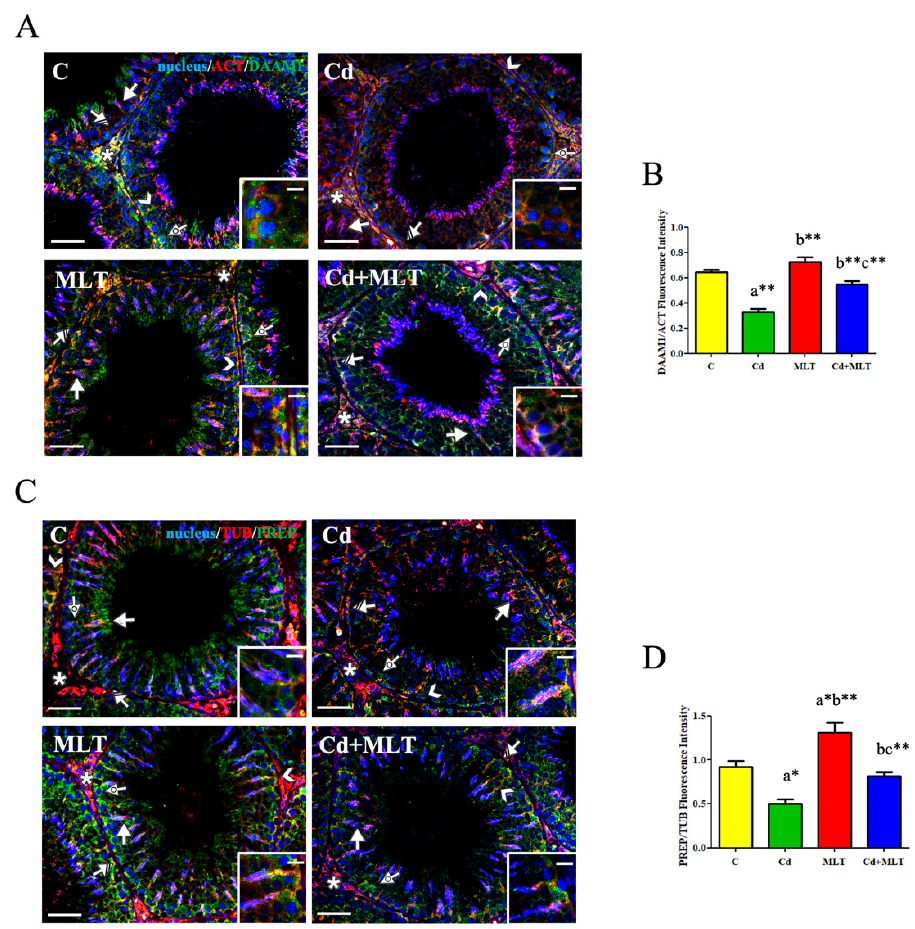
Figure 5. IF analysis on DAAM1 and PREP of C-, Cd-, and/or MLT-treated rat testis. ( A ) IF analysis of DAAM1 (green) and β -actin (red) in testes of animals treated with Cd and/or MLT. Slides were counterstained with DAPI-fluorescent nuclear staining (blue). Scale bars represent 20 µ m. ( B ) Histogram showing the quantification of DAAM1 fluorescence signal intensity using ImageJ. ( C ) IF analysis of PREP (green) and α -tubulin (red) in testes of animals treated with Cd and/or MLT. Slides were counterstained with DAPI-fluorescent nuclear staining (blue). Scale bars represent 20 µ m and 10 µ m in the insets. Striped Arrows: SPG; Dotted Arrows: SPC; Arrows: SPT; Arrowheads: SC; Asterisk: LC. ( D ) Histogram showing the quantification of PREP fluorescence signal intensity using ImageJ. All the values are expressed as means ± SEM from 6 animals in each group. a: significant difference versus C group, p < 0.05; b: significant difference versus Cd group, p < 0.05; c: significant difference versus MLT group, p < 0.05; *: p < 0.01; **: p < 0.001.